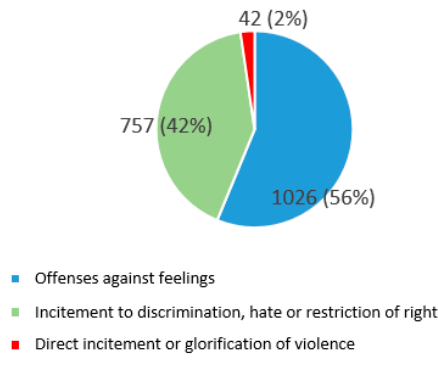
Figure 3. Types of detected hate speech.